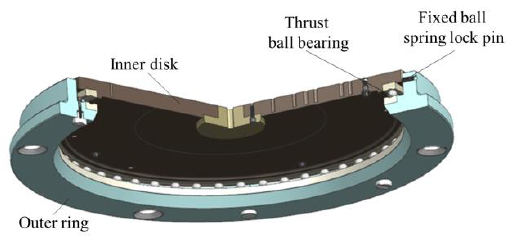
Figure 11. Model of function-switching mechanism.